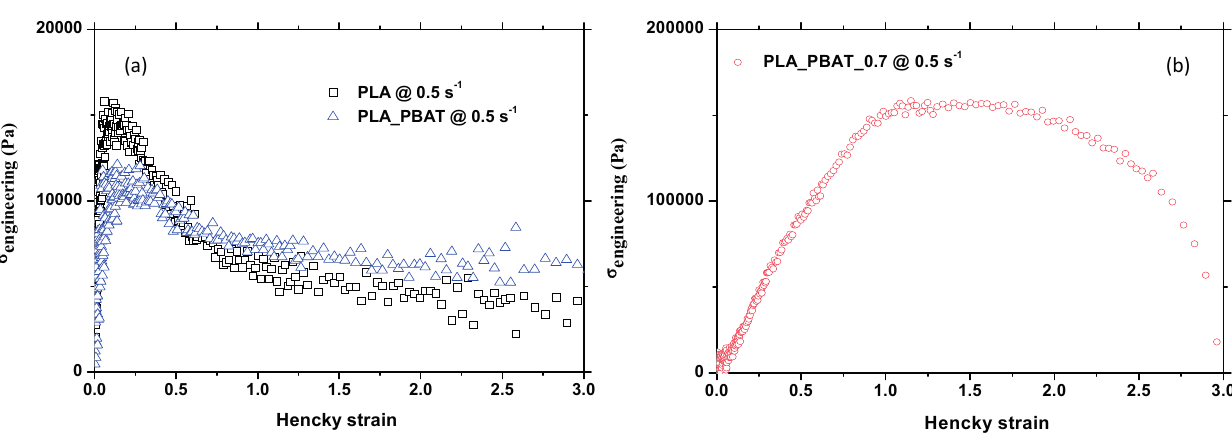
Figure 12. Example of engineering stress evolution at 0.5 s − 1 at 180 °C for ( a ) PLA and its uncompatibilized blend and ( b ) its compatibilized